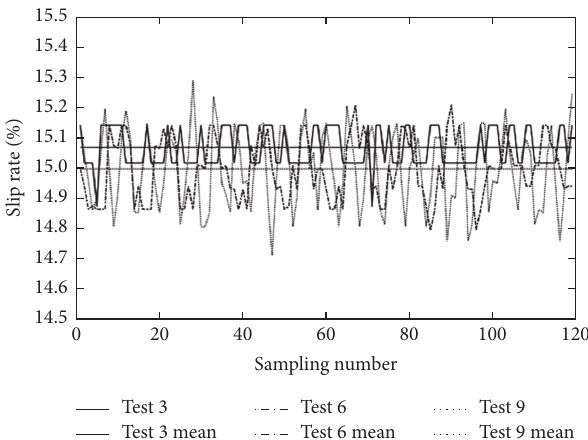
Figure 15: Tests 3, 6, and 9 slip rate statistics and mean